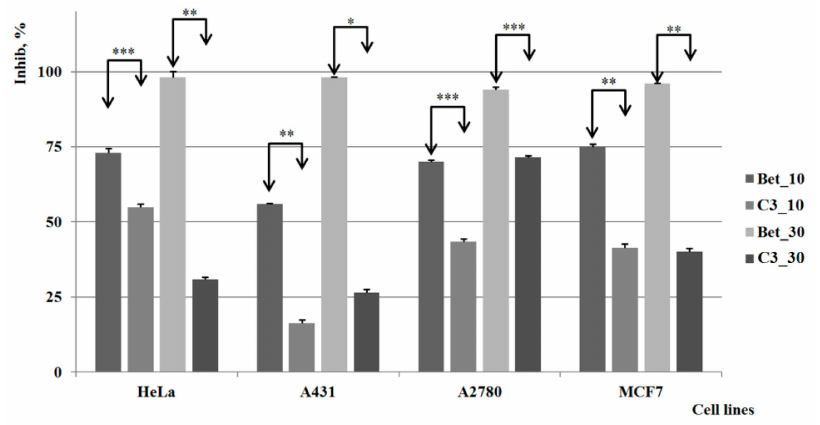
Figure 6. The results of the in vitro tests for C3 vs. control group (Bet) *, **, *** indicate p < 0.05, p < 0.01, and p < 0.001.